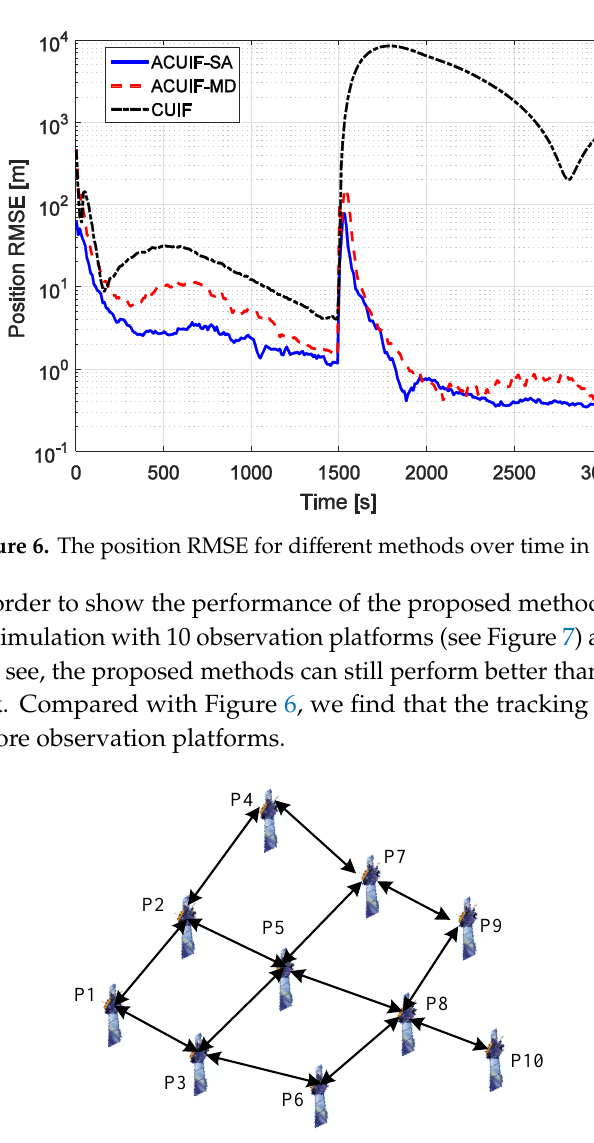
14 of 17 Figure 4. The position RMSE for different methods over time in case 1. In case 2, the target operates an orbital maneuver at 1500 s. The corresponding thrust vector is along the direction of the target velocity. And